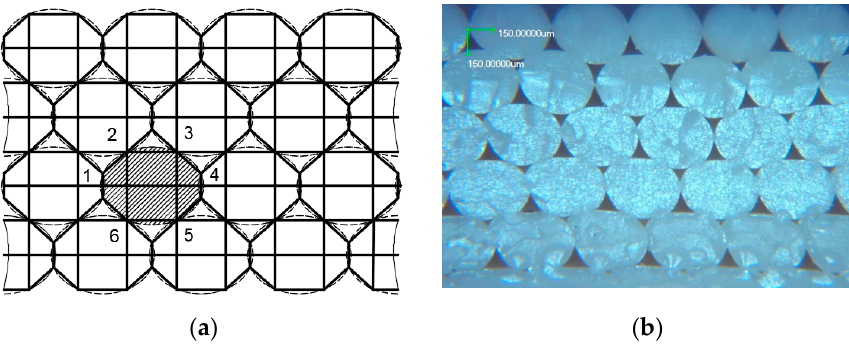
Figure 5. Tightly packed mesostructure of the 3D printed parts via FDM ( a ) FE modeling; ( b ) microscopic image of the printed part.